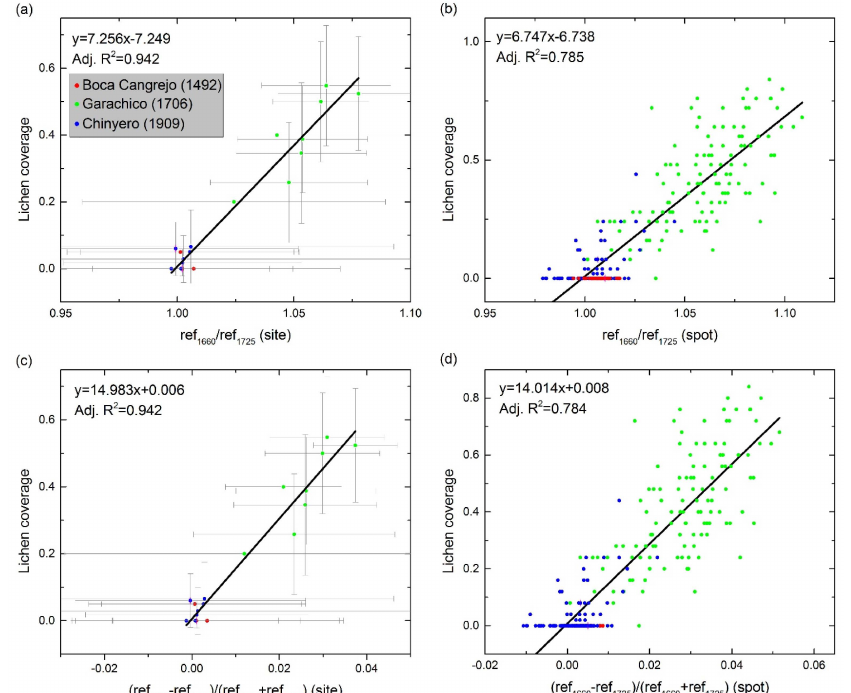
Figure 7. Relationship between lichen coverage observed in the field and the proposed lichen indices at site and spot scales. ( a ) (ref 1660 /ref 1725 ) vs. lichen coverage at site scale; ( b ) (ref 1660 /ref 1725 ) vs. lichen coverage at spot scale; ( c ) ((ref 1660 ´ ref 1725 )/(ref 1660 + ref 1725 )) vs. lichen coverage at site scale; ( d ) ((ref 1660 ´ ref 1725 )/(ref 1660 + ref 1725 )) vs. lichen coverage at spot scale. The site scale graphs include the 19 lava sites measured on the Garachico, Boca Cangrejo and Chinyero lava flows in 2013 and 2014, and the spot graph includes 260 spots belonging to the sites measured in 2014 only. Standard deviations for lichen coverage and spectral indices were calculated based on the measurements at the spot scale for each site. In order to enhance the visibility, one tenth of the standard deviations were shown for the spectral indices. The large variations for the spectral indices are because 1660 nm and 1725 nm are in the SWIR range that is easily affected by atmospheric conditions and errors propagate through multiple mathematical